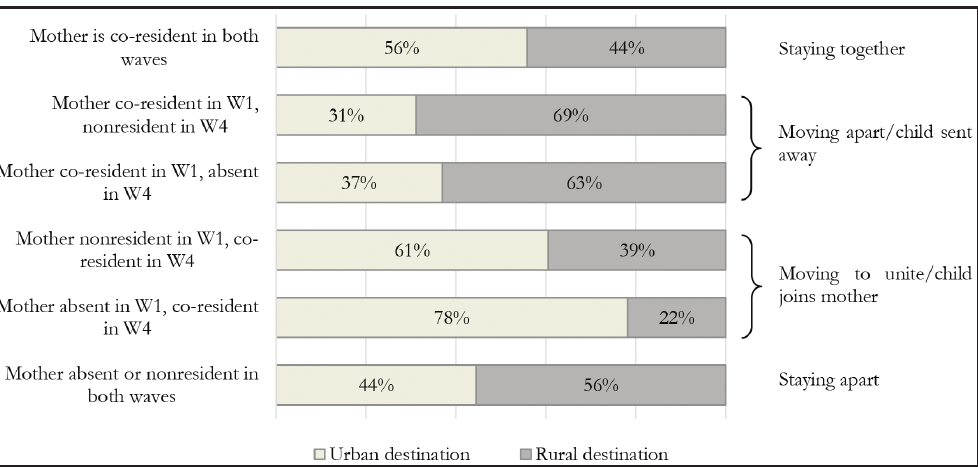
Figure 1 Urban/rural location of receiving households for child migrants in wave 4, by change in maternal co-residence status over waves